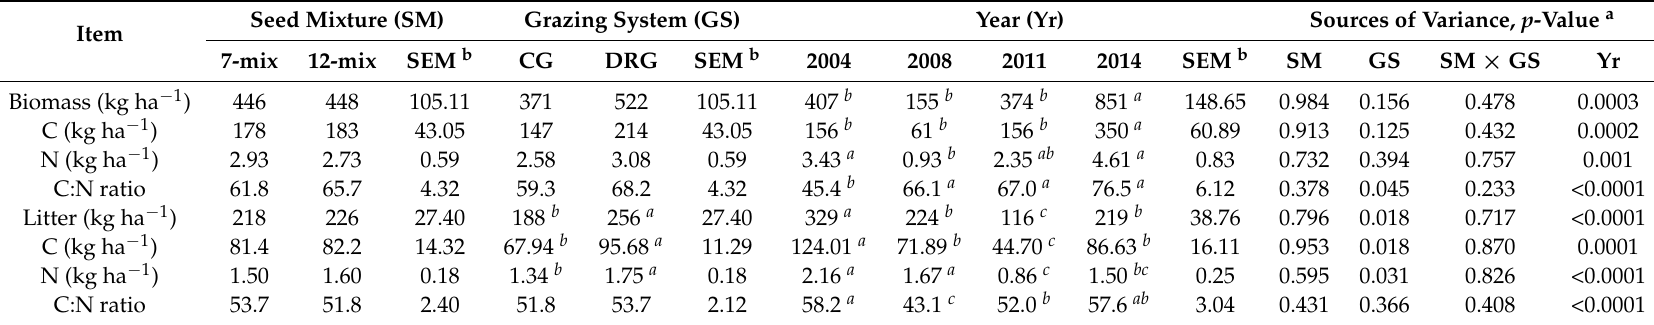
Table 5. Effect of seed mixture (SM, 7-mix, 12-mix), grazing system (GS, continuous grazing (CG), deferred rotational grazing (DRG)) and year (Yr) on pasture above ground biomass and litter carbon (C) and nitrogen (N) content ( n =